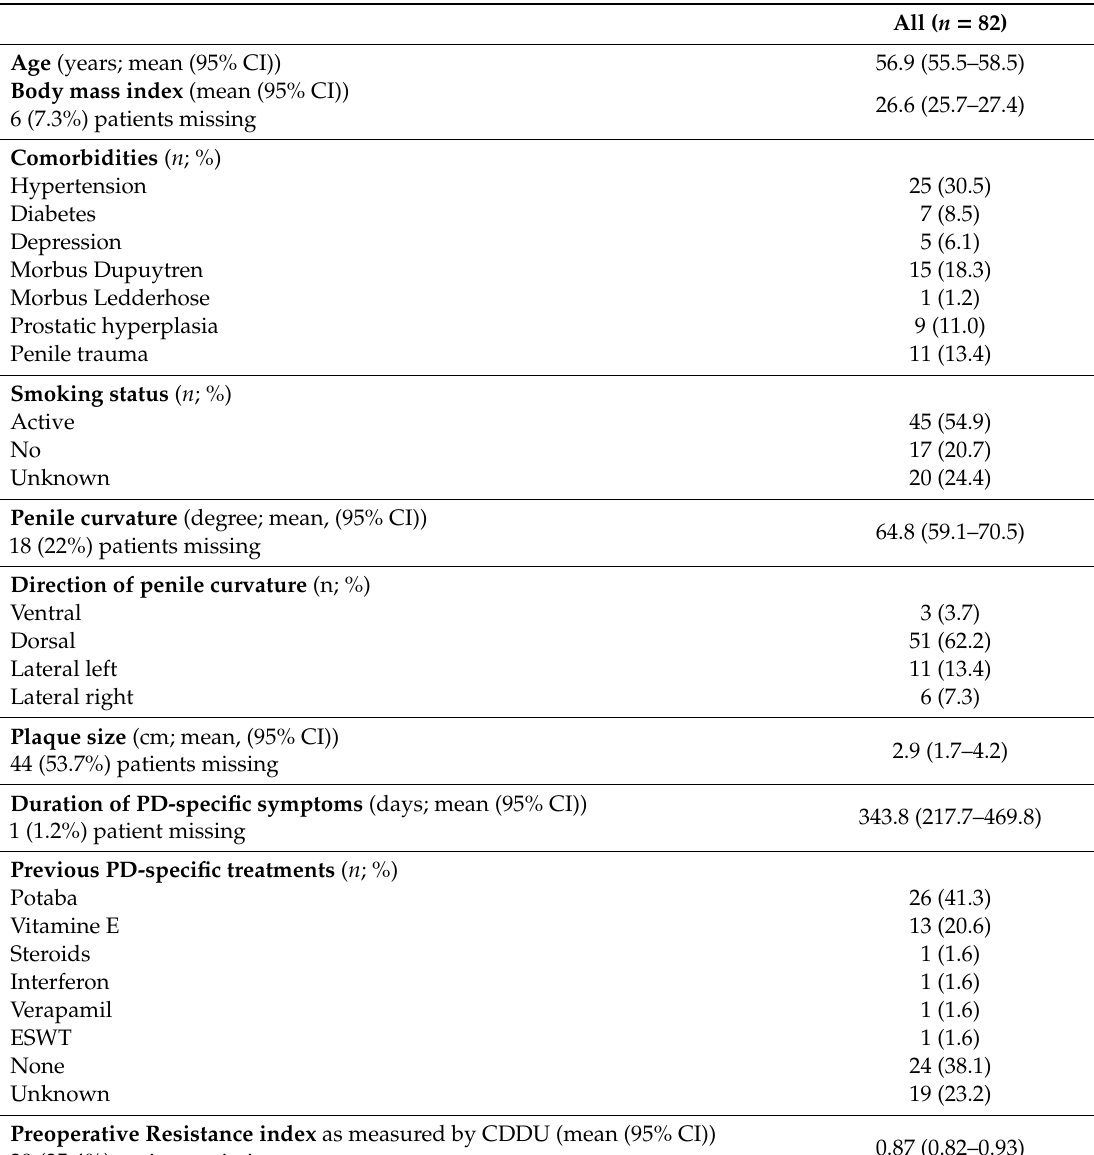
Table 1. Clinical characteristics of 82 patients treated with small intestinal submucosa grafting for Peyronie’s